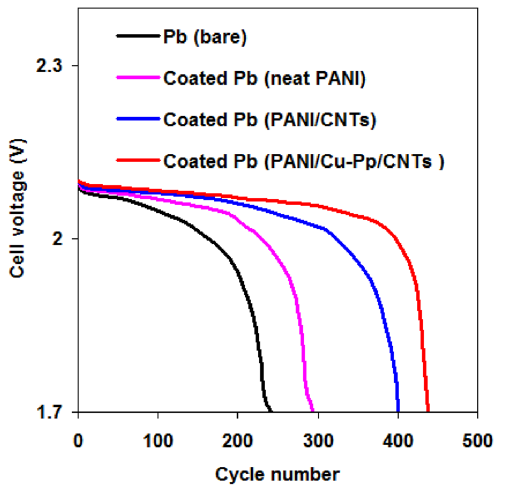
Figure 7. Dependence of cell voltage on cycle numbers using different negative